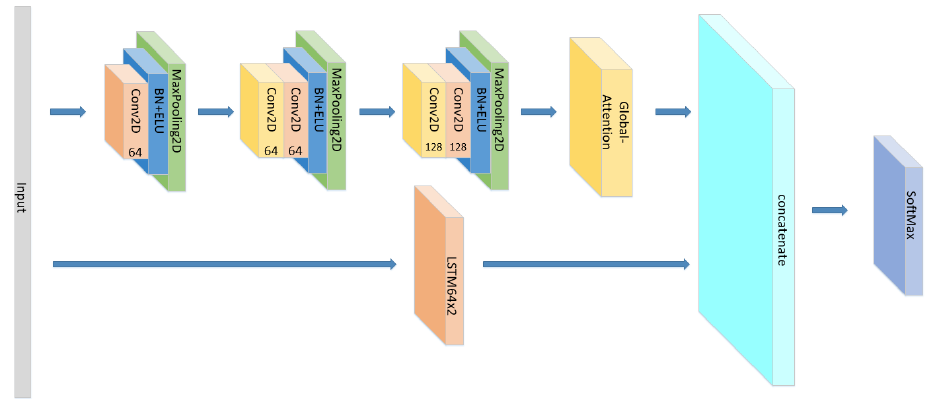
Figure 20. The structure of the CNN//LSTM×2+Global-Attention.